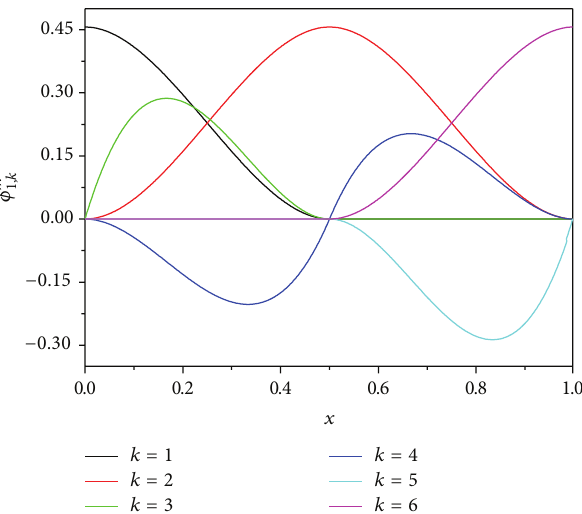
Figure 2: Modified scaling functions in scaling space 𝑉 1